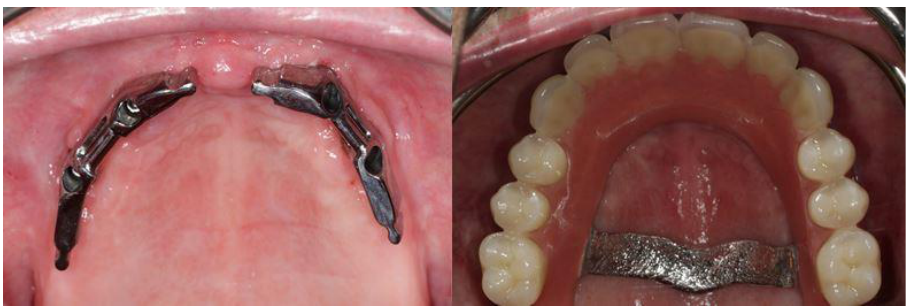
Figure 6. Bar-retained overdenture.